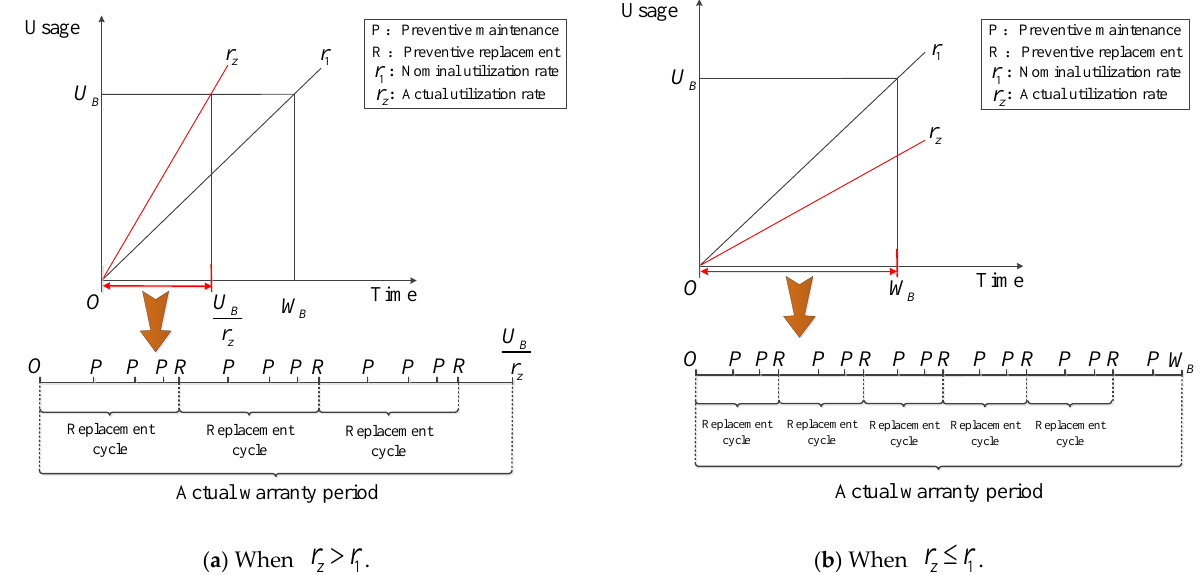
Figure 5. Schematic diagram of the warranty periods under different utilization rates. In Figure 5,